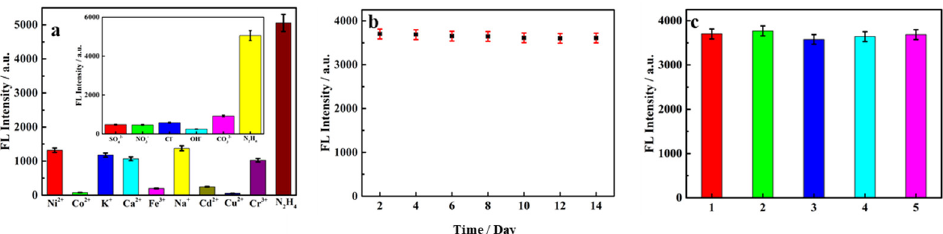
Figure 7. ( a ) The effect of different cations and anions on the fluorescence intensity of SQDs@MnO 2 NS fluorescent probe; ( b ) the fluorescence intensity stability of SQDs in two weeks; ( c ) the reproducibility of SQDs in 5 groups.